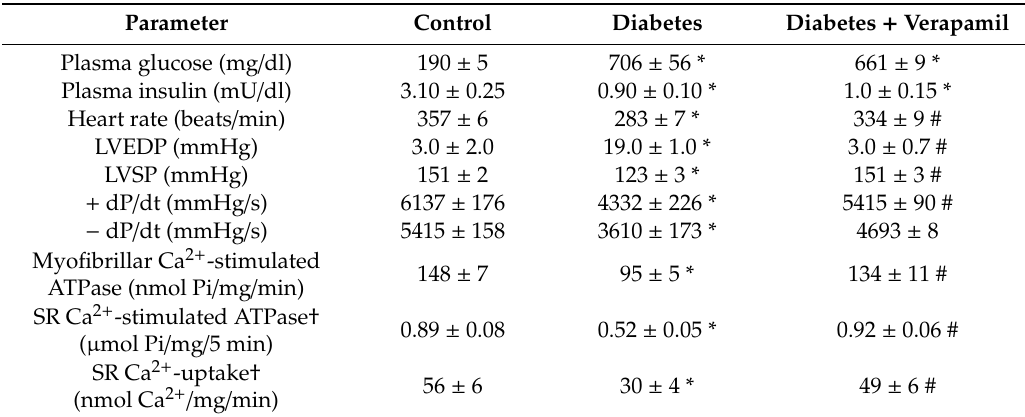
Table 3. Plasma glucose / insulin levels, hemodynamic parameters and subcellular activities of control, diabetic and verapamil-treated diabetic animals. Parameter Control Diabetes Diabetes +